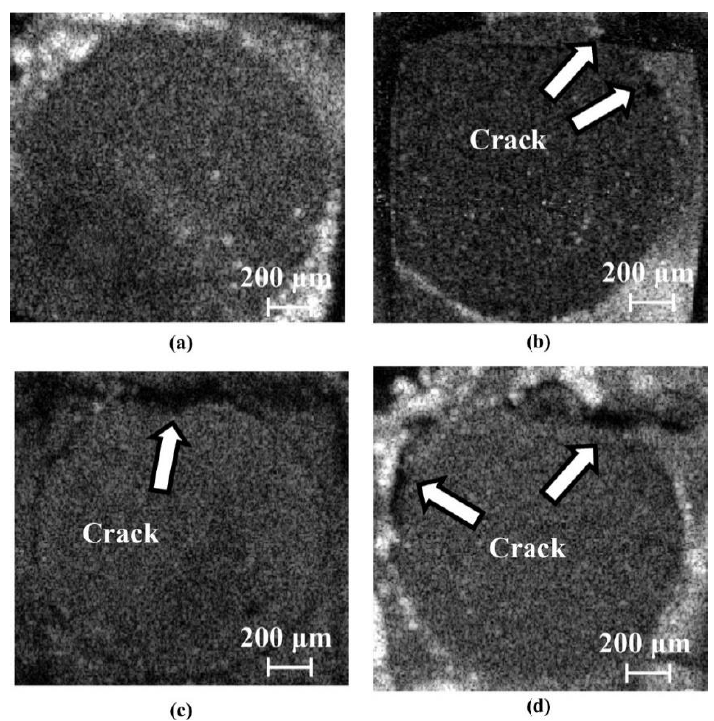
Figure 11. OCT images of ceramic/enamel interface under ( a ) an 80% load with 21 cycles, ( b ) an 80% load with 205 cycles, ( c ) a 70% load with 4071 cycles and ( d ) a 60% load with 38,271 cycles. Adapted with permission from Ref. [113] 2022, Elsevier.